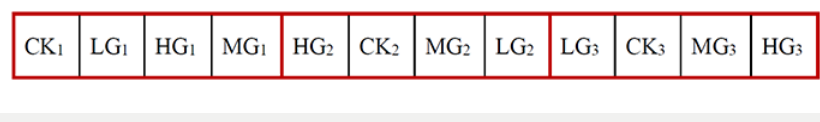
Figure 1 e schematic diagram of experimental site. Red rectangles represent three blocks, and black rectangles represent different treatments.